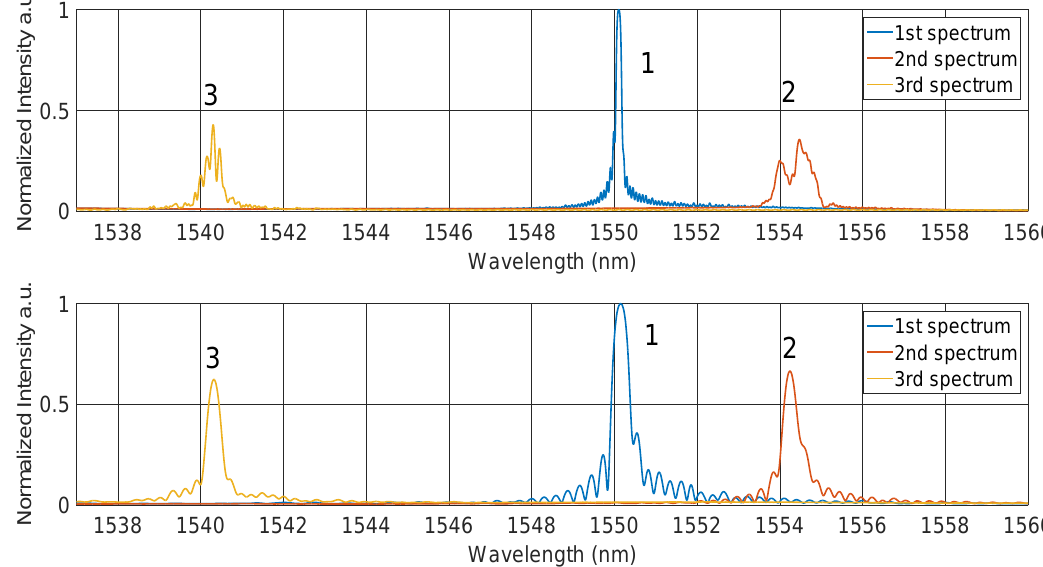
Figure 16. Comparison of the reflected spectra of an 8-mm FBG (upper graph) and a shorter FBG with a length of 3–4